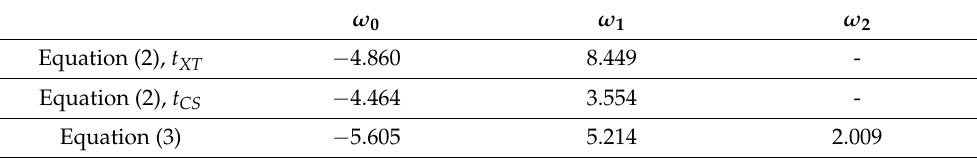
Table 3. Coefficients of Equations (2) and (3) for the models built on the collected